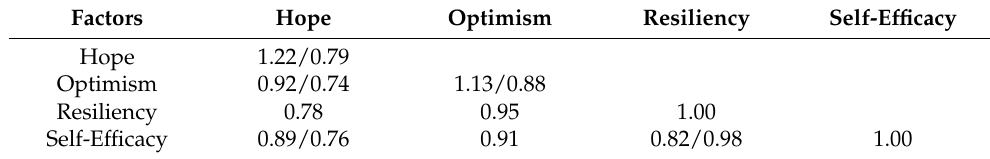
Table 4. Interfactor correlation of the four factors of the PsyCap scale between